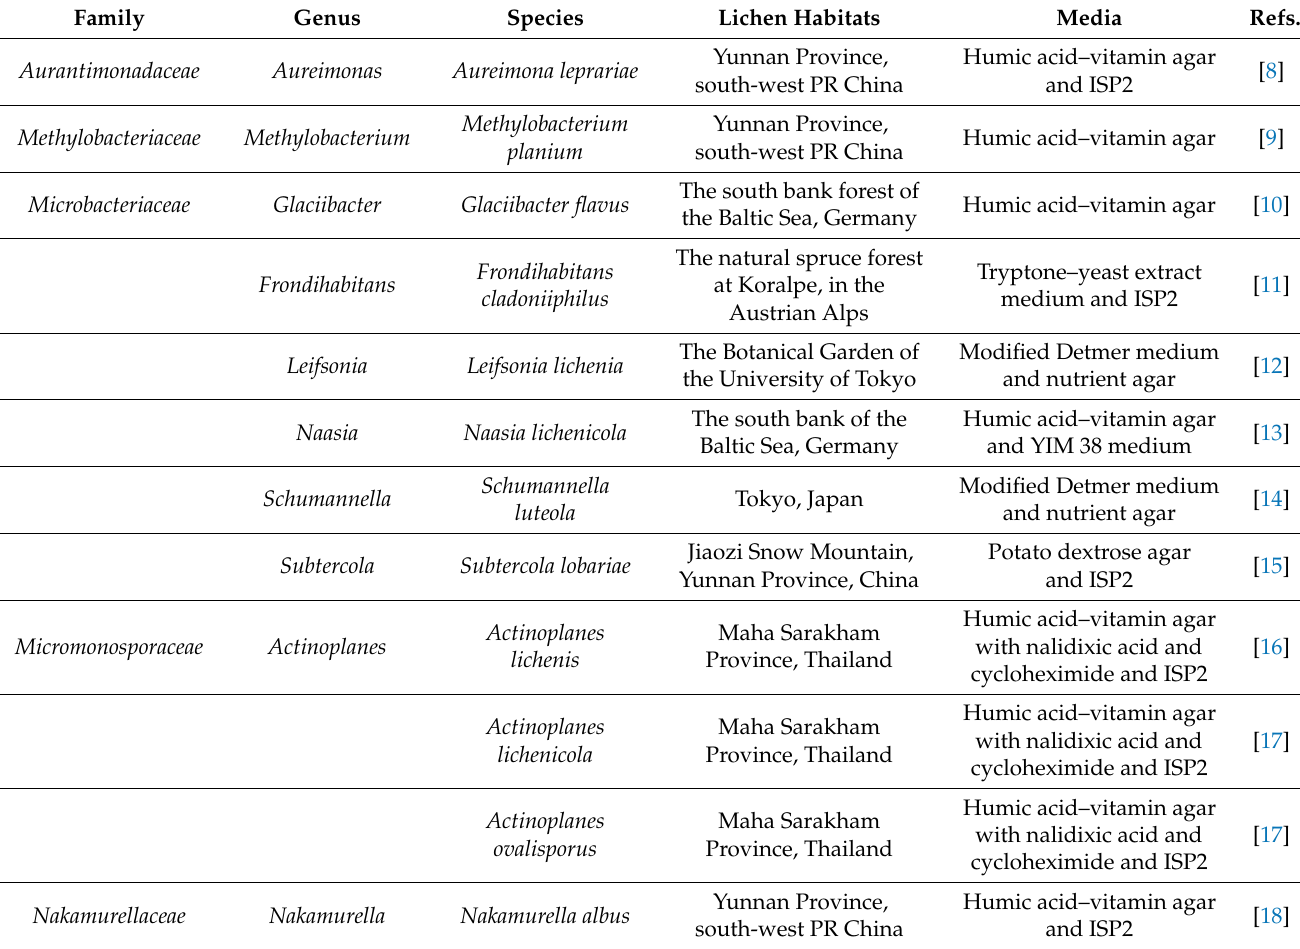
Table 1. Novel actinomycetota taxa isolated from lichens between 2007 and